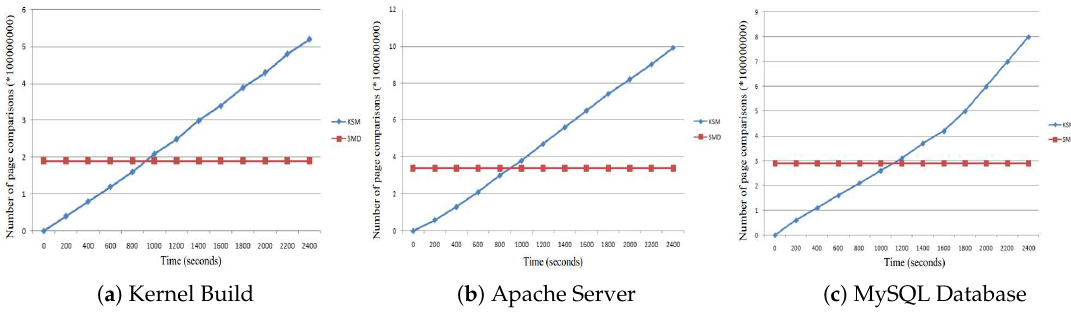
Figure 13. The number of page comparisons of different workloads with four VMs.